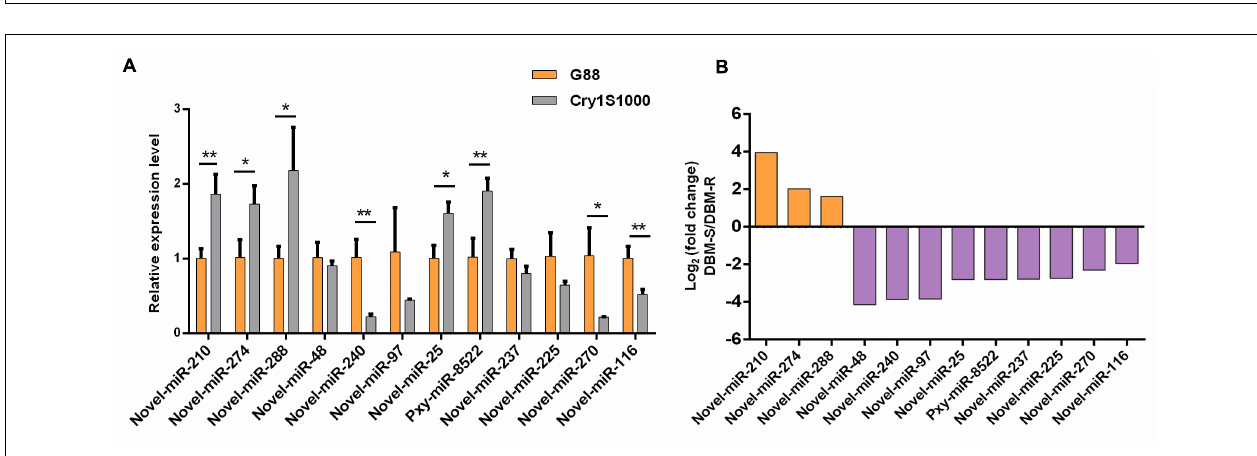
FIGURE 6 | The most enriched KEGG pathways based on the genes targeted by differentially expressed miRNAs in the resistant (Cry1S1000) and susceptible (G88) strains. The X-axis shows the number of genes annotated to the pathway and the ratio of the number of annotated genes to the total genes annotated, and the Y-axis shows the pathway names. The different color of column indicates different type of KEGG pathway.